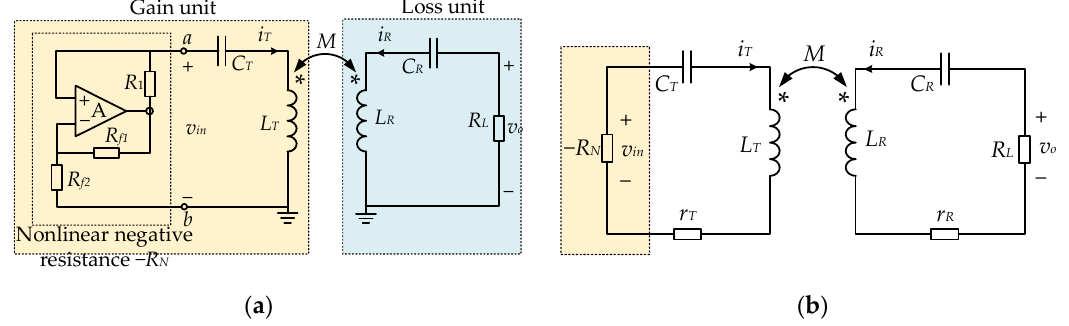
Figure 1. Schematic of single-load PT-WPT system using series-series topology with nonlinear negative resistance represented in operational amplifier form: ( a ) the circuit topology; ( b ) the equivalent circuit diagram.